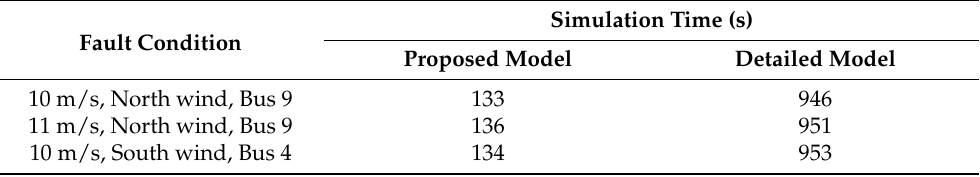
Table 7. Simulation time comparison of equivalent model and detail